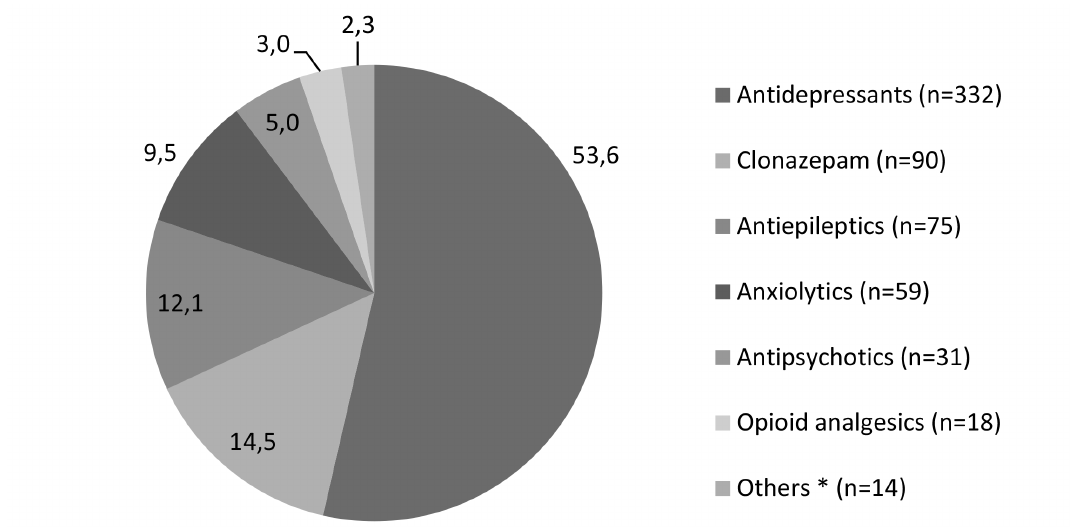
FIGURE 2 - Frequency of prescribed PAD according to ATC classification (n=619), December 2012. ATC: Anatomical Therapeutic Chemical; PAD: psychoactive drugs; *Hypnotics/sedatives and centrally acting antiobesity